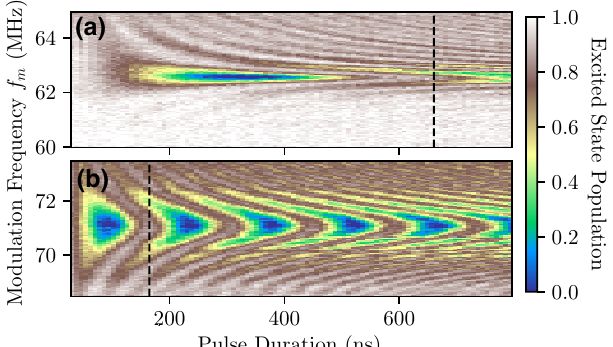
FIG. 6. Excited state population of qubit 6, undergoing | 1 (cid:5) ↔ | 0 (cid:5) transfer during a CZ interaction mediated by the k = − 8 side- band of qubit 5’s f 12 transition frequency. Population exchange at each resonance condition is visualized by sweeping pulse duration and fundamental modulation frequency for constant modulation amplitude at the respective sweet spot. Panel (a) features the monochromatic instance of this gate, while panel (b) features a bichromatic operating point selected for increased sideband weight ε − 8 (not the same operating point featured in Fig. 5, which has lower fidelity due to a collision). The frequency axes of both panels have the same scale, highlighting the relative resonance widths that scale with coupling strength. The black dotted lines correspond to fit durations of a full CZ interaction, showing a bichromatic speed-up by almost exactly a factor of 4 after pulse risetimes are included in total duration. The bichro- matic gate has an interleaved randomized benchmarking fidelity of 98.8% ± 0.50%, compared to the 92.7% ± 2.15% fidelity of the monochromatic gate.